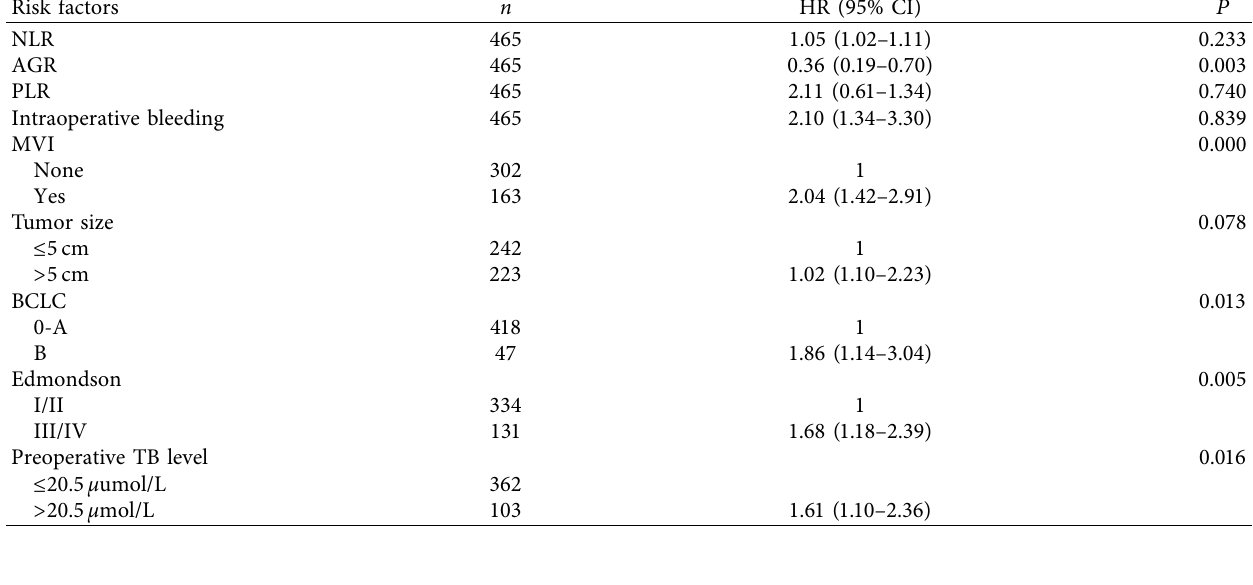
Table 2: Multivariate Cox regression analysis of mortality risk after curative resection of hepatitis B-related